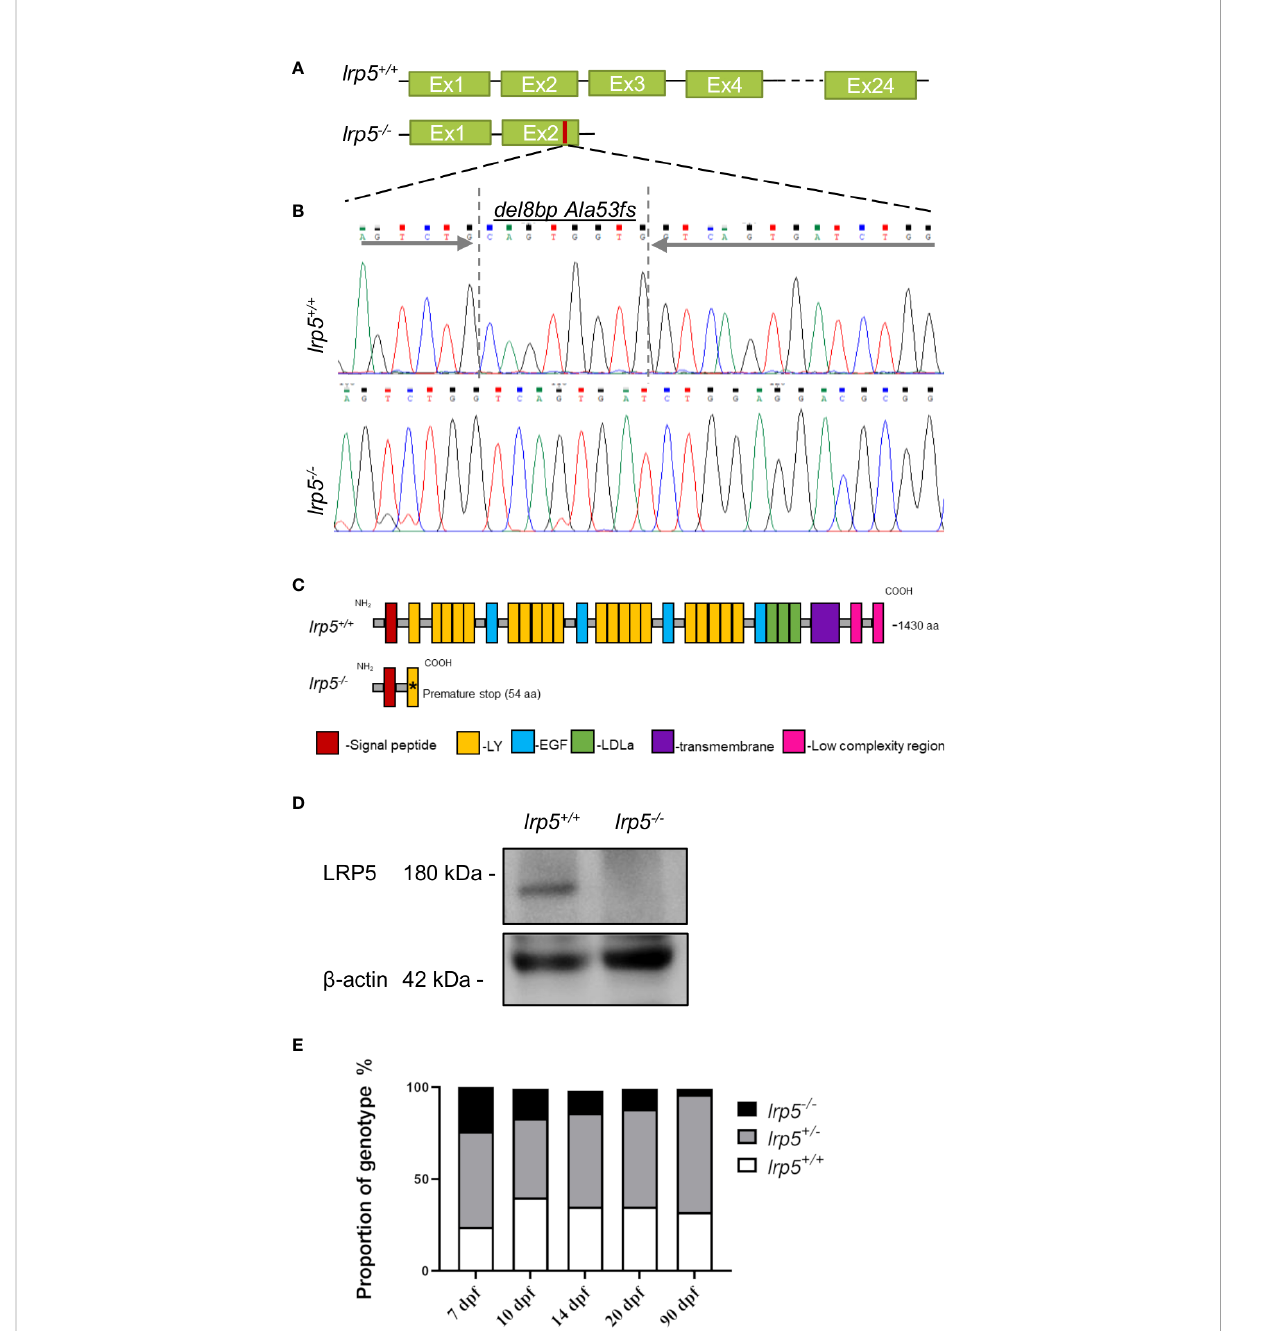
FIGURE 1 CRISPR-Cas9 induced lrp5 zebra fi sh knockout line. (A) Schematic representation of the ZF lrp5 gene structure with Sanger sequence chromatogram; (B) demonstrating the del8bp (Ala53fs) mutation, that results in a frameshift and a premature stops codon; (C) Schematic representation of the ZF LRP5 wild-type and mutated protein demonstrates the lack of functional domains in LRP5 of lrp5 -/- (LY -low-density lipoprotein receptor; EGF – epidermal growth factor; LDLa- Low-density lipoprotein receptor domain class (A, D) Western-blot results demonstrated the absence of LRP5 protein in lrp5 -/- . (E) Each column in the graph represents the proportion of genotype (%) per developmental stage. Only 3.7% of lrp5 -/- in survive and reach adolescence using instead of expected